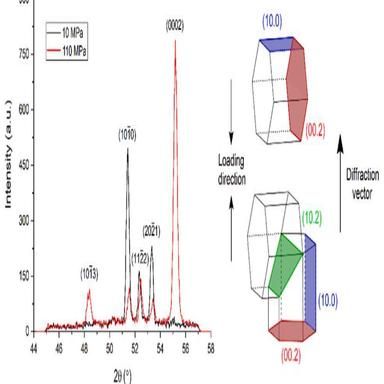
An evolution of the diffraction pattern of the RD sample from 10 MPa to 110 MPa, illustrating the effect of activation of extension twinning on the changes of peak intensities, together with a schematic illustration of extension twinning-induced lattice reorientation with respect to loading direction and the diffraction vector.